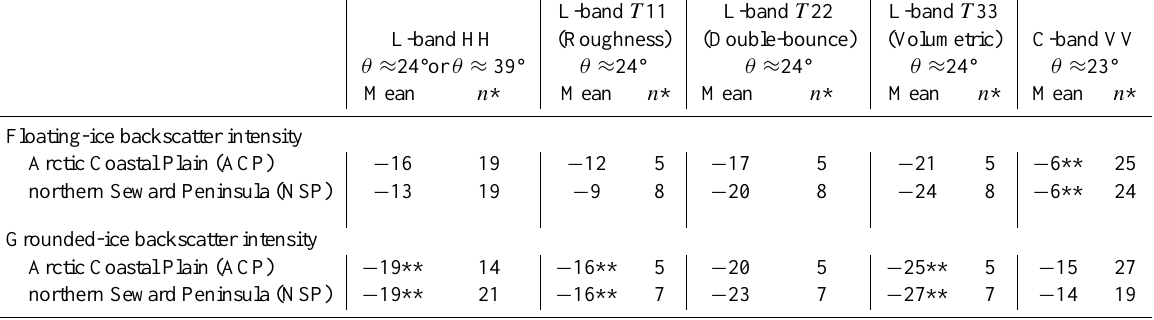
Table 2. Summary of mean SAR backscatter intensity (dB) from floating and grounded lake ice for L- and C-bands from both study